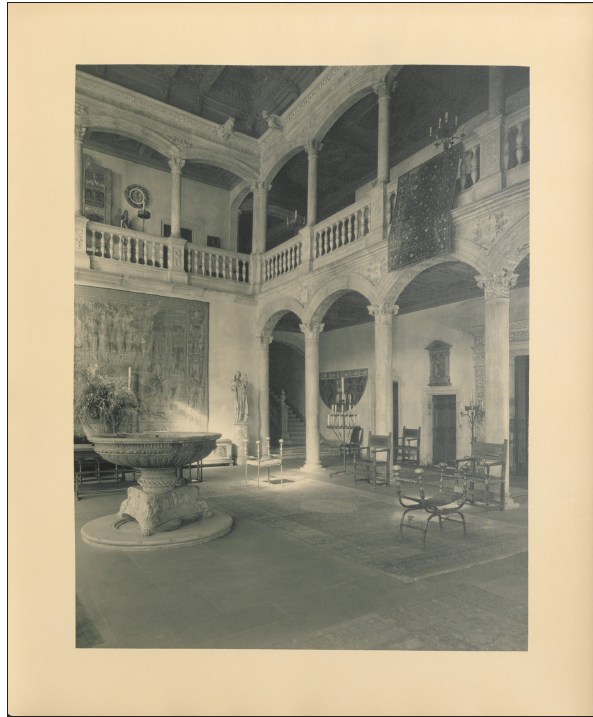
Fig. 1 : The home of George and Florence Blumenthal, 50 East 70th Street, New York, 1920s, print, Metropolitan Museum of Art, New York (inv. 106.1 B622 Folio). © The Metropolitan Museum of Art/Art Resource,